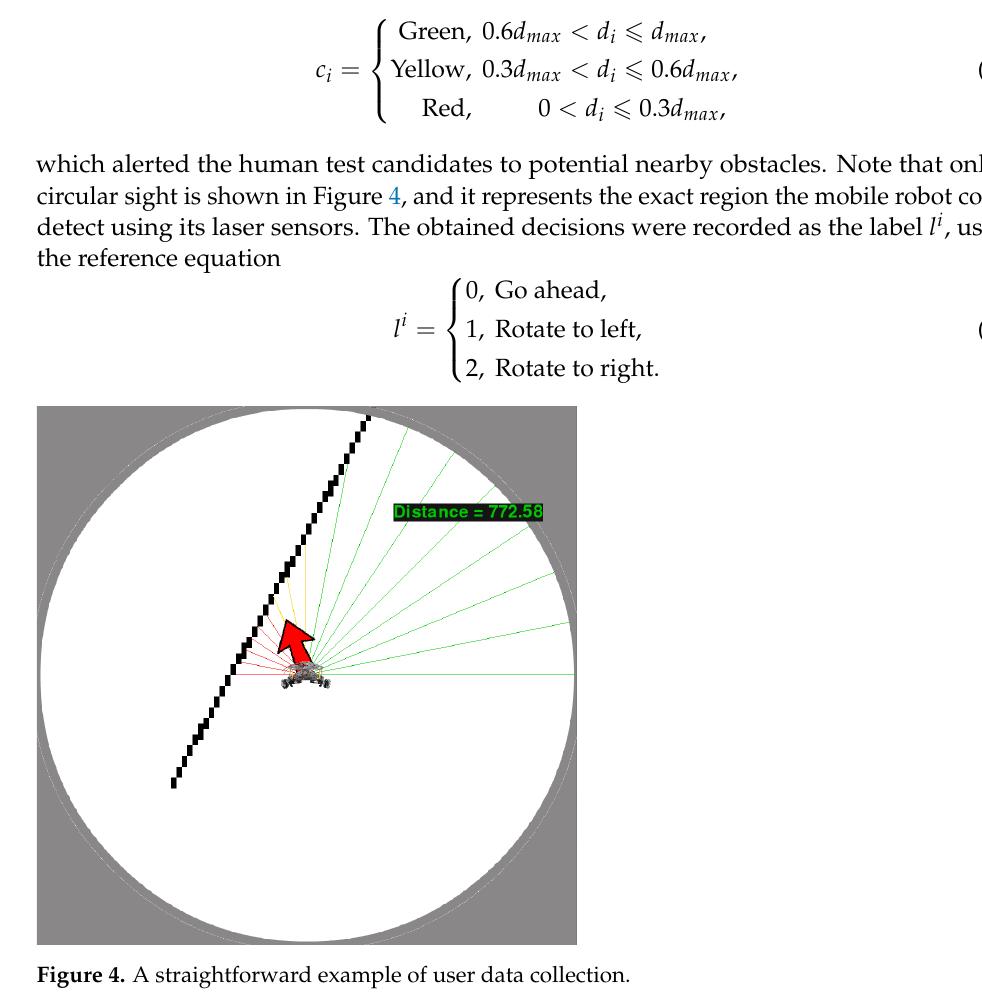
mental information d i , i = 1, . . . , 17 and φ i , which formed a complete labeled